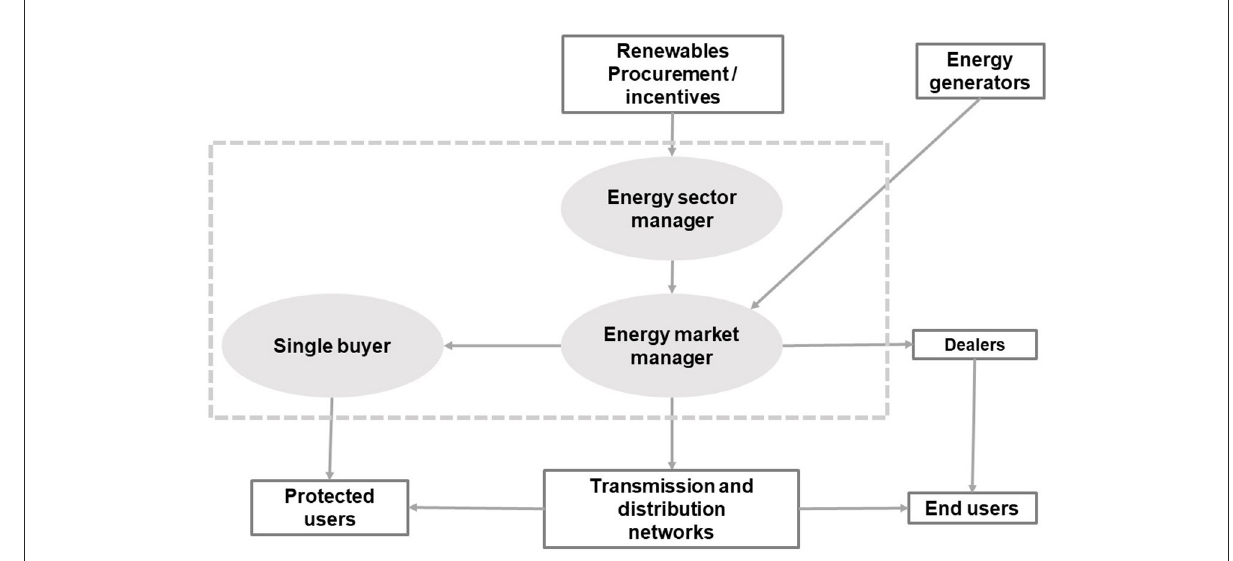
FIGURE2 Independent body supporting market functioning in the energy